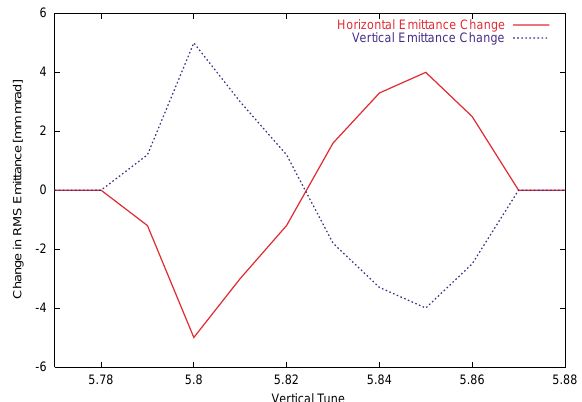
FIG. 1. (Color) The change of the horizontal and vertical rms emittances as a function of zero-current tune n y for fixed n x (cid:1) 5.82 .